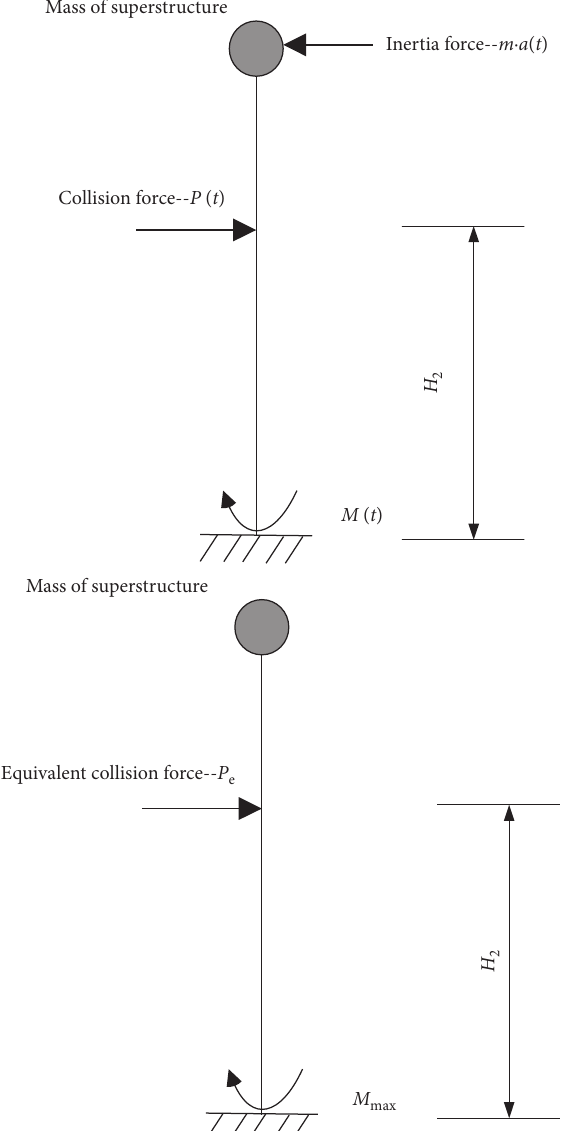
Figure 9: Schematic diagram of the calculation of equivalent collision